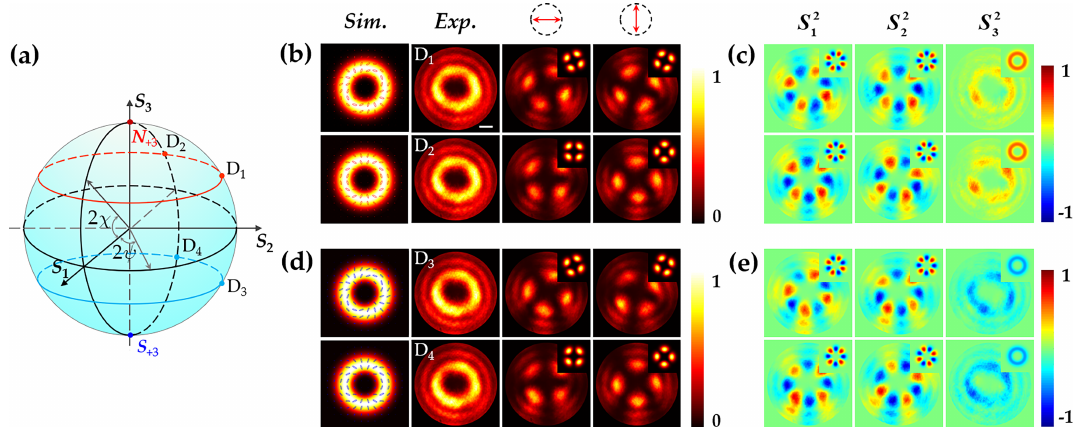
Figure 4. Simulated and experimental results of generated cylindrical VBs when both C1 and C2 were inserted in the system. ( a ) The position of generated cylindrical VBs on HOP sphere, which are signed by D1 to D4 with coordinate ( − 0.188 π , π /2 ) , ( − 0.188 π , π ) , ( 0.143 π , π /2 ) and ( 0.143 π , π ) , respectively; ( b , d ) are intensity pattern of generated cylindrical VBs at point D1 to D4; ( c , e ) are corresponding Stokes parameters distribution. The first row of ( b , d ) shows the simulated polarization states and intensity pattern of generated cylindrical VBs, while the other rows from left to right are intensity pattern measured without polarizer and after polarizer with directions 0 ◦ and 90 ◦ , respectively. The corresponding simulated results of intensity pattern and Stokes parameters distribution are shown in insets. Scale bar in the first experimental intensity pattern of D1 represents 0.645